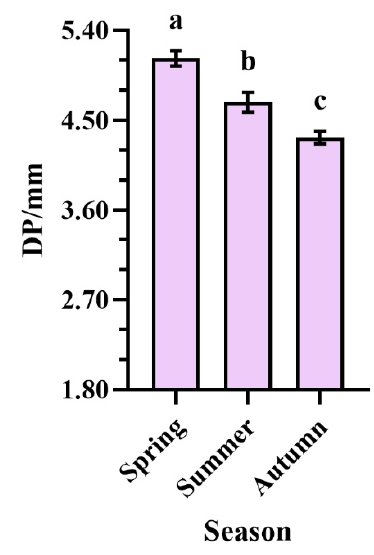
Fig 6 . Comparison of depth ( DP ) between maximum diameter and bottom of swarm cell.